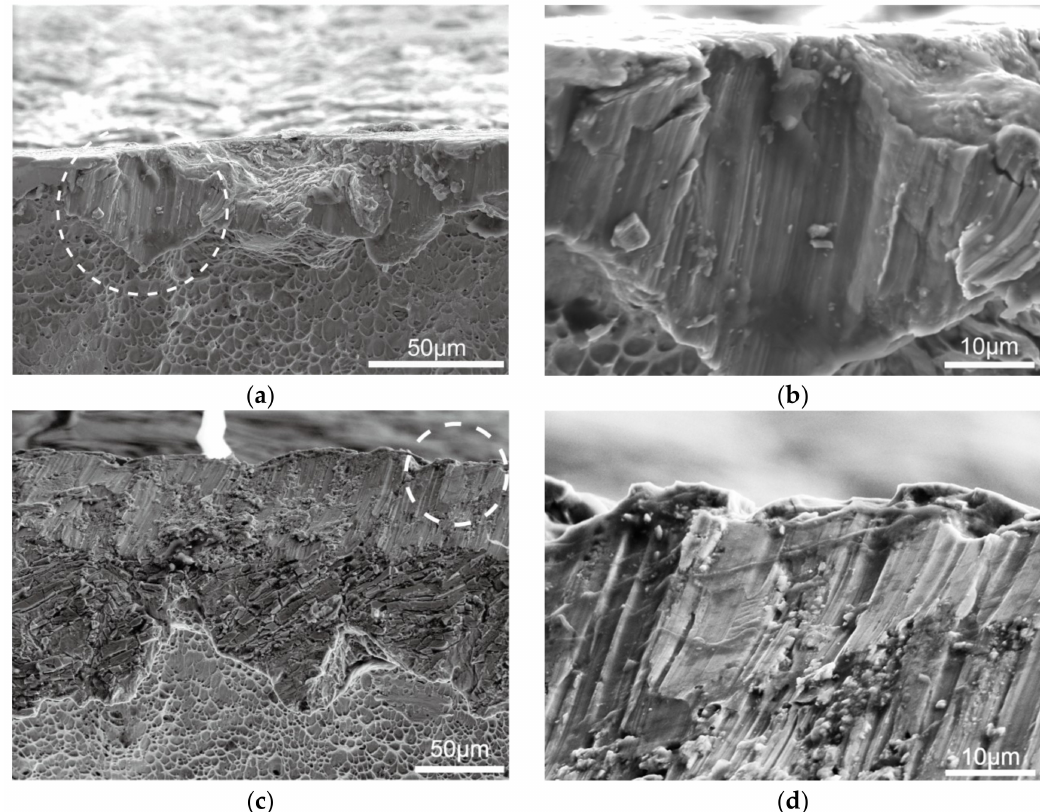
Figure 14. Brittle fracture area morphology of the coated sample. ( a ) Brittle fracture area morphology of the CrN coated sample, ( b ) fracture morphology in the white dashed circle of ( a ) at high magnification, ( c ) Brittle fracture area morphology of the TiN coated sample, ( d ) fracture morphology in the white dashed circle of ( c ) at high